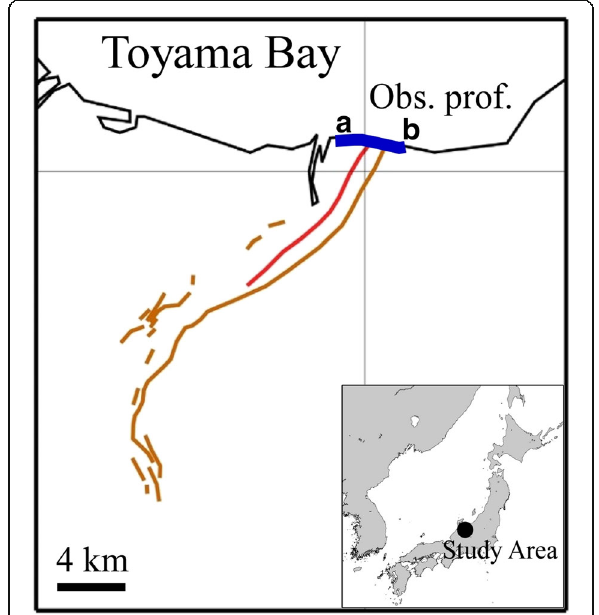
Fig. 7 Location map of the study area. Kurehayama Fault is a reverse fault located in the center of the Toyama Basin, Toyama Prefecture, Japan. Its location has been estimated by topographic, geological, and geophysical data. The red line and brown lines denote the estimated location of the Kurehayama Fault, Toyama City (Toyama City 2013), and The Headquarters for Earthquake Research Promotion (The Headquarters for Earthquake Research Promotion 2008), respectively. Blue line a - b indicates the dense gravity survey profile,